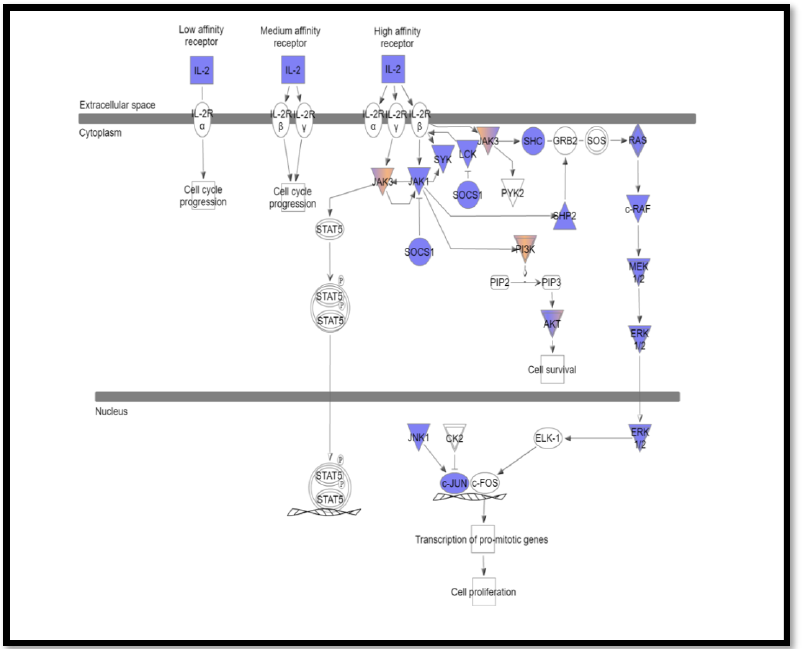
Figure 1. IL-2 signaling pathway identified using ingenuity variant analysis (IVA). Blue represents loss of function, and orange represents gain of function.